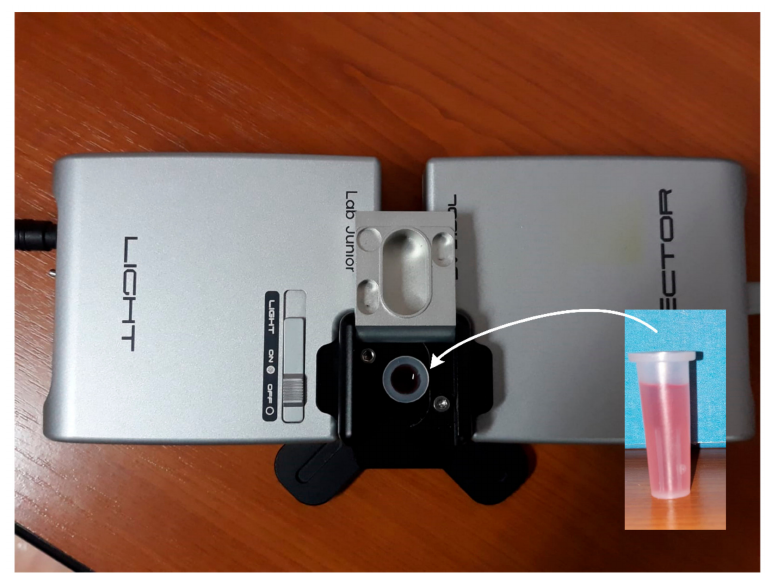
Figure 12. Test setup, consisting of a TH 2100 Tungsten Halogen source and SV 2100 spectrometer, for the acquisition of the reference absorption spectra of the wine samples in plastic cuvettes.